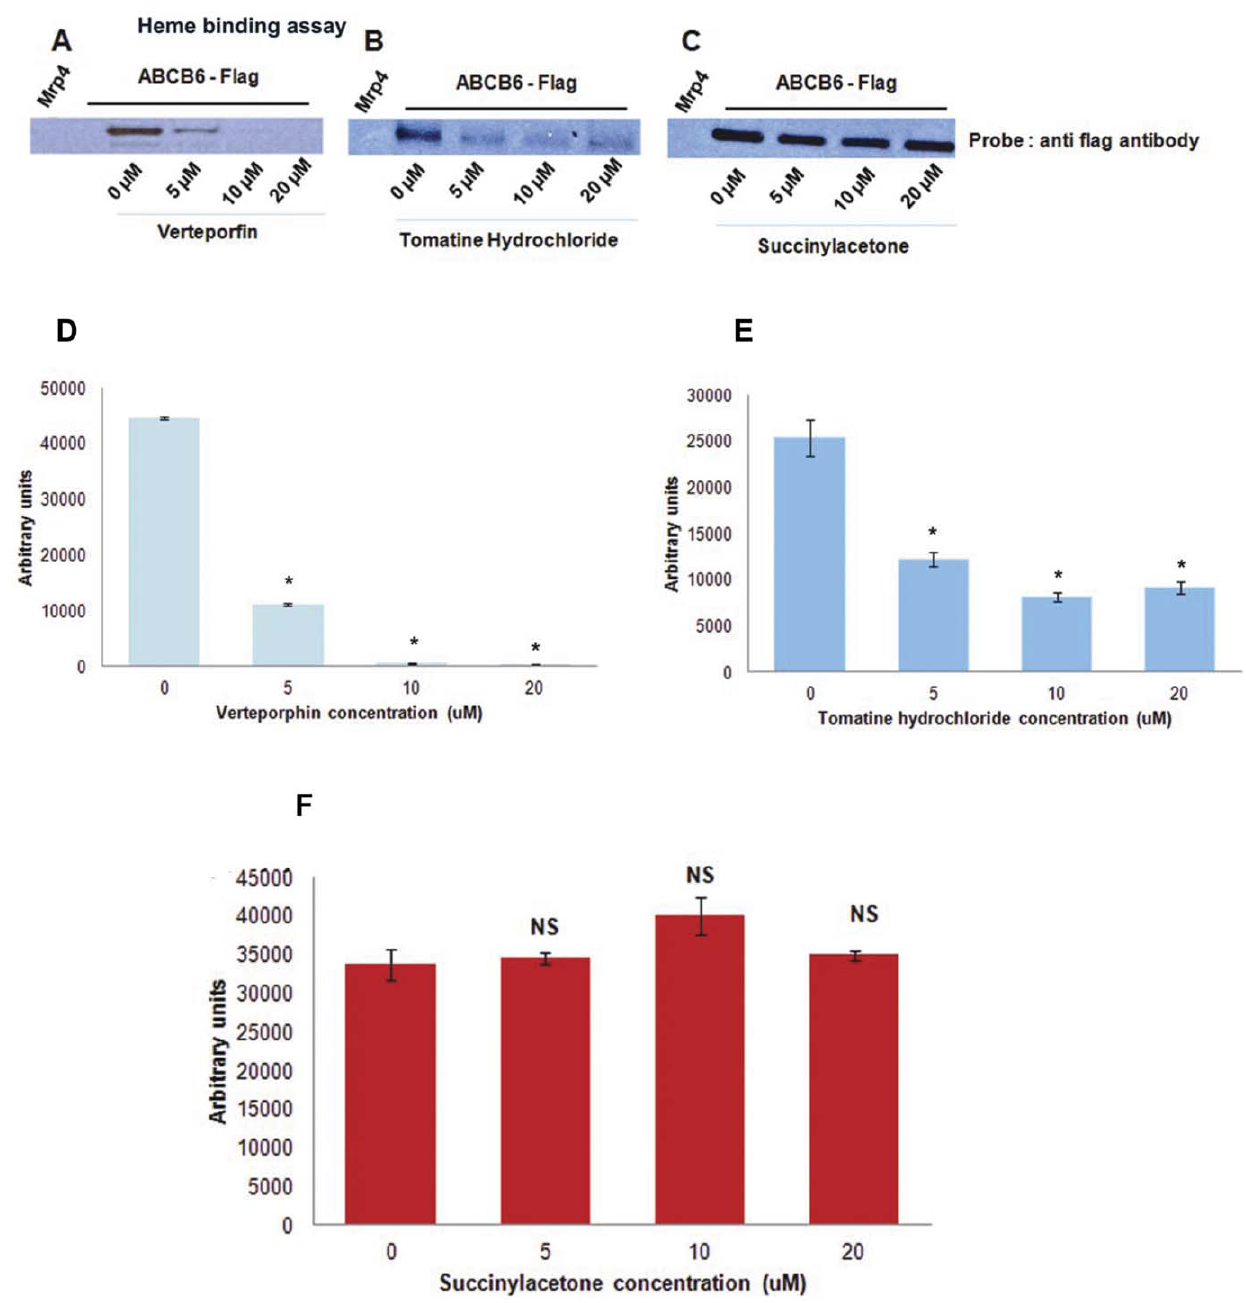
Figure 5. Selectivity and validation of HTS identified compounds by hemin agarose affinity chromatography. (a) verteporfin and (b) tomatine hydrochloride potently disrupt the interaction between ABCB6 and hemin-agarose compared with (c) succinylacetone. (d, e and f) image J analysis of ABCB6 band intensity treated with (d) verteporfin, (e) tomatine hydrochloride and (f) succinylacetone averaged over three independent experiments. Mitochondria isolated from K562 cells expressing ABCB6-Flag or the empty vector were incubated in the presence or absence of increasing concentration of the indicated compound and hemin-agarose and the resulting complex was immunoblotted using a monoclonal antibody to the flag-tag. Results are representative of 3 independent experiments. ‘*’ significantly different from untreated controls. P , 0.05. ‘NS’ differences are non-significant compared to untreated control.